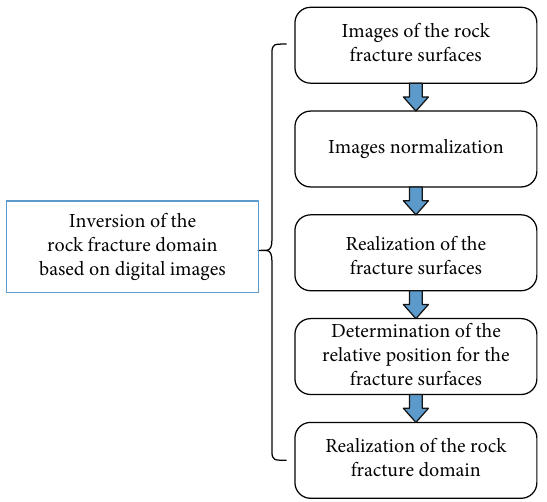
Figure 1: Process chart of inverting the fracture